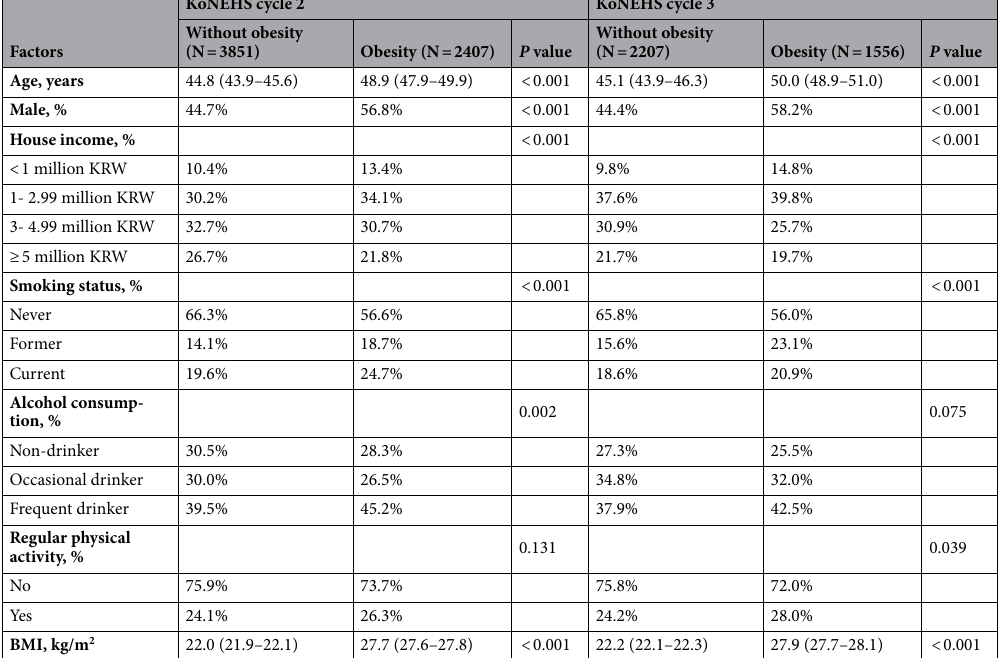
Table 1. Characteristics of participants in KoNEHS Cycle 2 and Cycle 3 according to obesity status. Obesity status was classified based on BMI. Values are presented as mean (95% confidence intervals) or percentage (%). KRW, South Korean Won; BMI, body mass